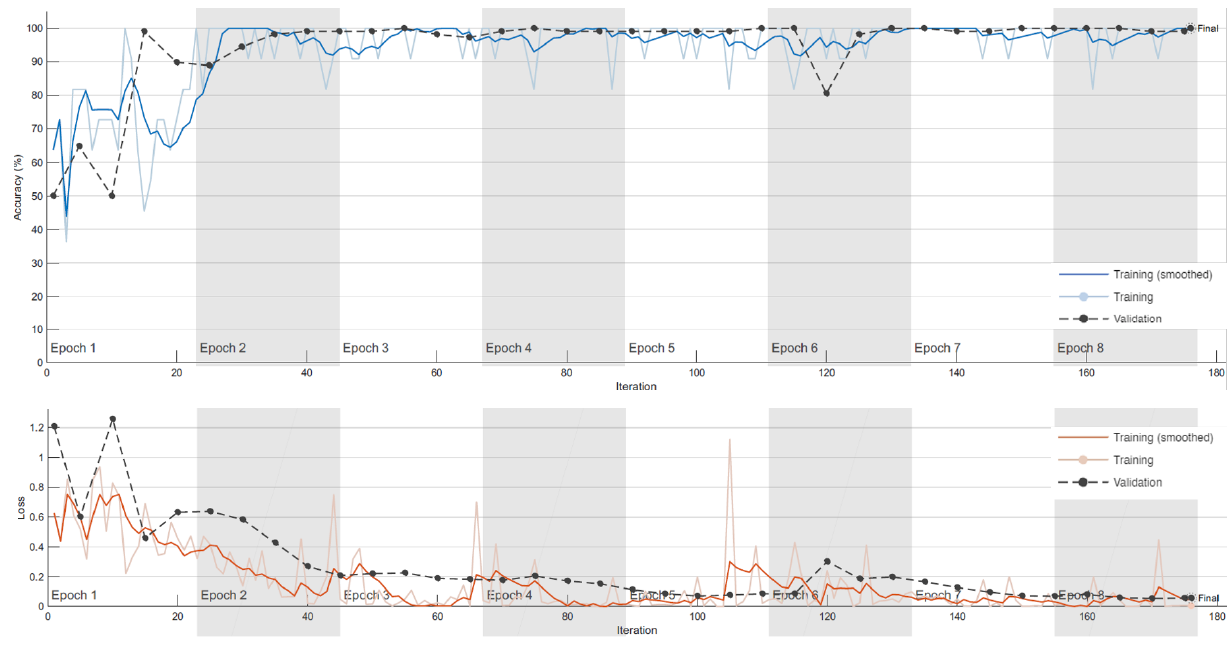
Figure 10. Accuracy and loss in the training and validation phase.